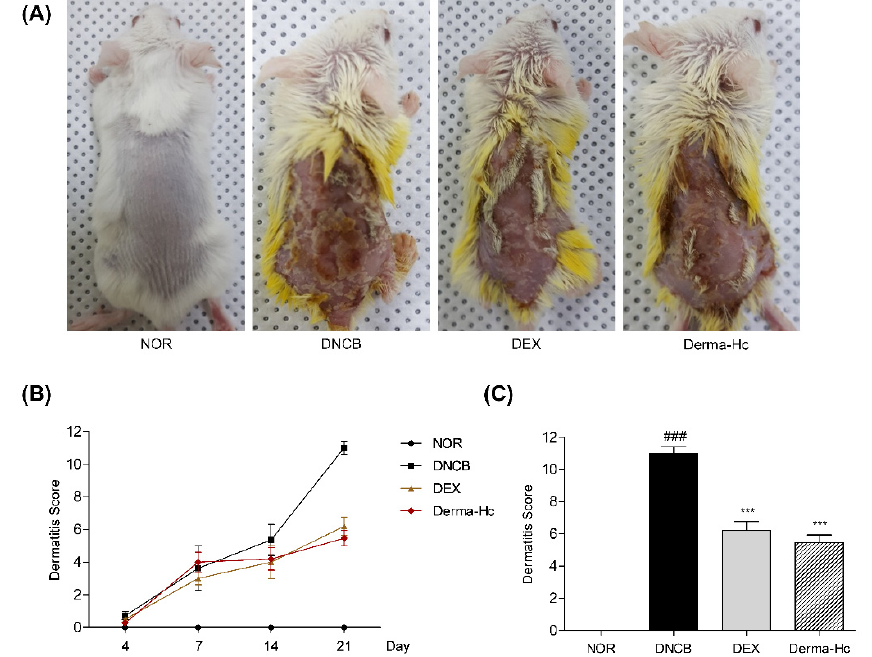
Figure 1. Derma-Hc attenuates the development of atopic dermatitis in DNCB-induced mice. NOR, Normal saline-treated group; DNCB, 2,4-dinitrochlorobenzene (DNCB)-sensitized group; DEX, DNCB-sensitized and dexamethasone-treated group. ( A ) Photographs of the dorsal skin lesions from individual groups of 5-week-old male BALB/c mice ( n = 5) at the end of the experiment (Day 21). ( B , C ) The dermatitis score was measured on the basis of atopic dermatitis-like symptoms including erythema/hemorrhage, scarring/dryness, edema, and excoriation/erosion. The data are presented as mean ± standard error of the mean. ### p < 0.001 compared to NOR group. *** p < 0.001 compared to individual groups.